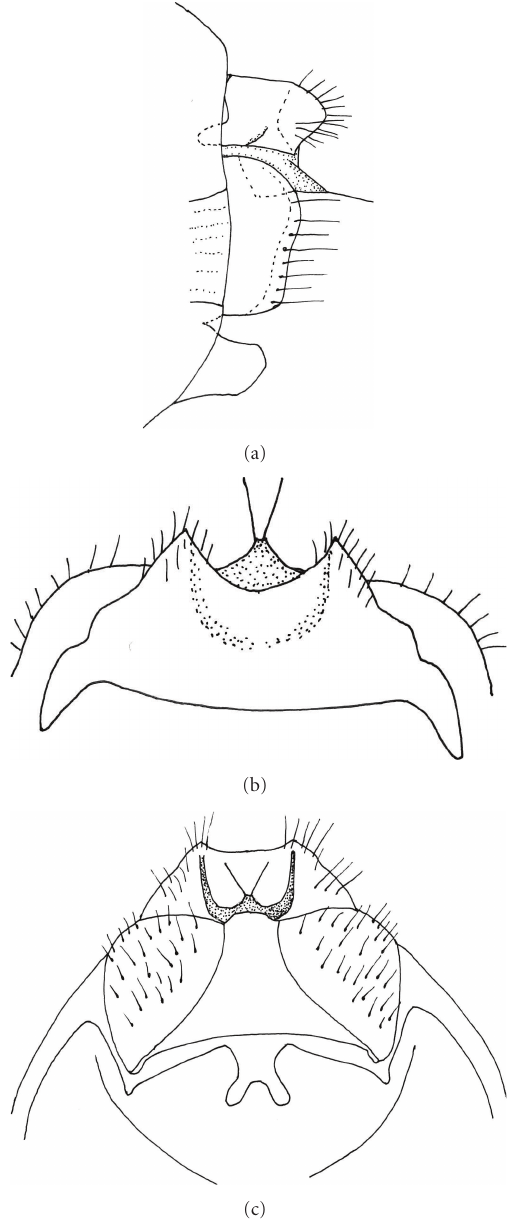
Figure 4: Chaetopteryx sinopica sp.n., female genitalia: (a) lateral; (b) dorsal; (c) ventral.